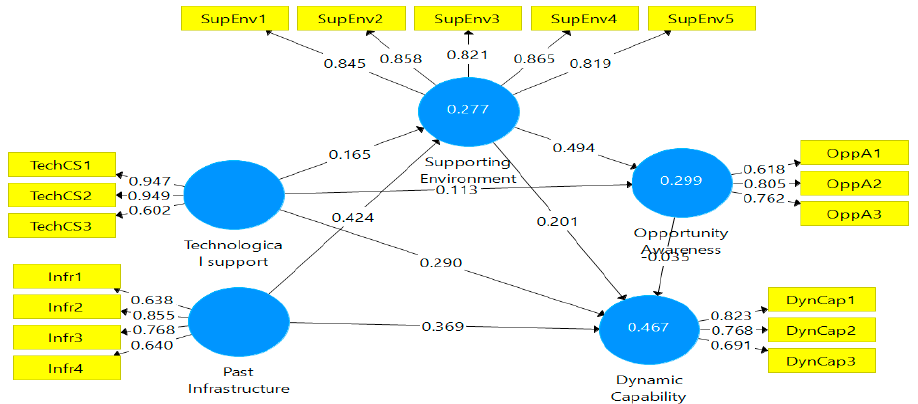
Figure 2. The path model (Source: Smartpls3 output). All significant relationships satisfy the 1.96 minimum requirement for a 5% margin of error. The R 2 of the three endogenous variables varies with the dynamic capability to obtain the highest value. This revelation is understandable as all paths finally end in this